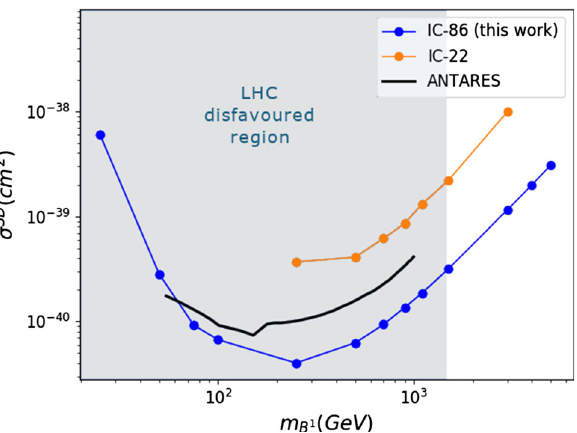
Fig. 6 90% confidence level upper limit on the spin-dependent B 1 - proton scattering cross section as a function of B 1 mass. Blue curve (IC-86): this work. Orange curve (IC-22): previous IceCube limit on LKP cross section from the 22-string IceCube configuration [21]. Black line: limits from ANTARES [23]. Limits from IceCube have been eval- uated at the discrete masses denoted by the dots. Lines are just a linear interpolation between the dots to guide the eye. The shaded area repre- sents the disfavoured region (at 95% confidence level) on the mass of the LKP from the LHC [33]